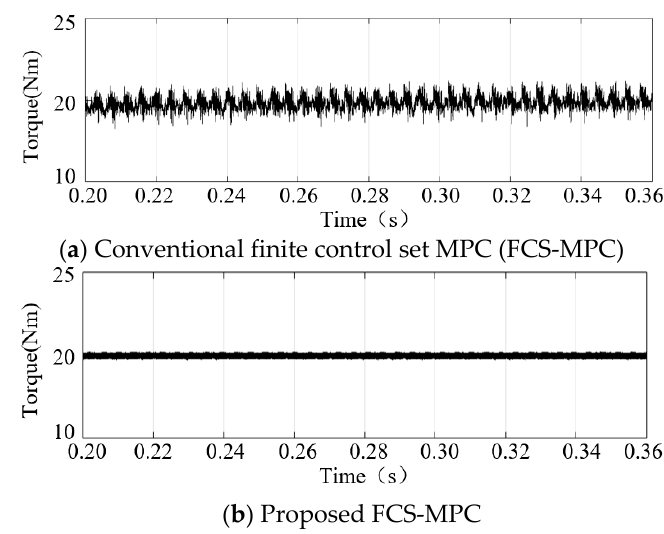
Figure 6. Torque steady-state response simulation.